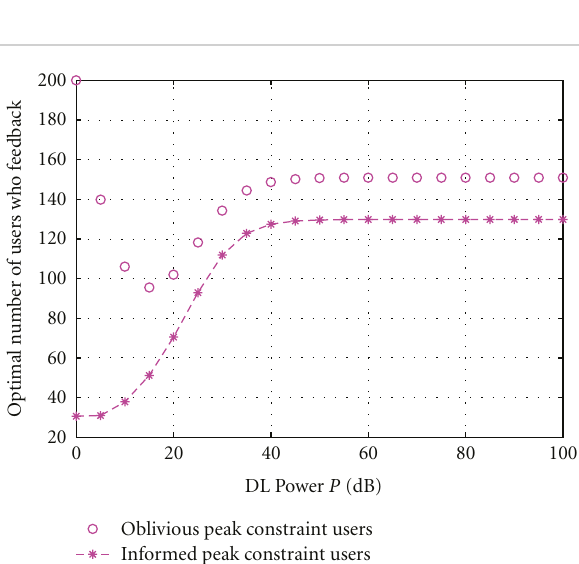
Figure 5: Optimal Number of Users versus DL Power P